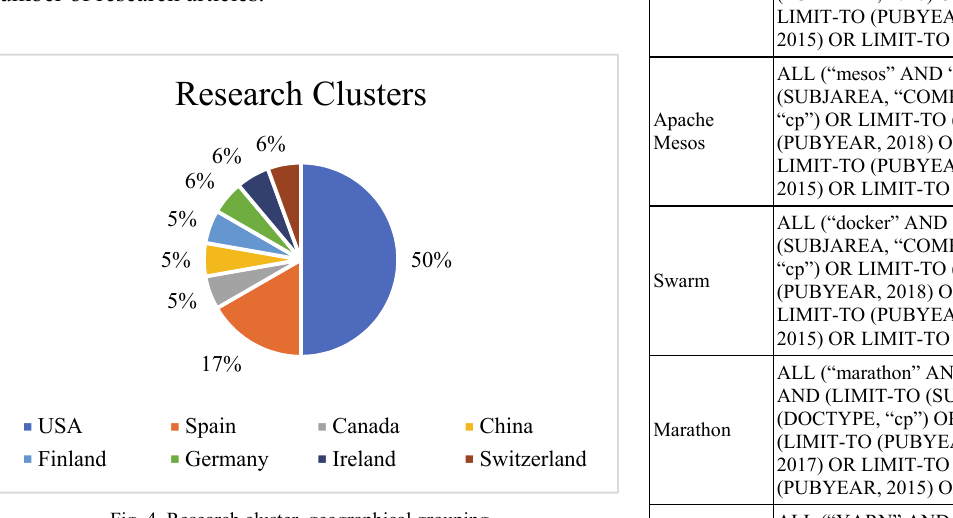
Fig. 4. Research cluster, geographical grouping.